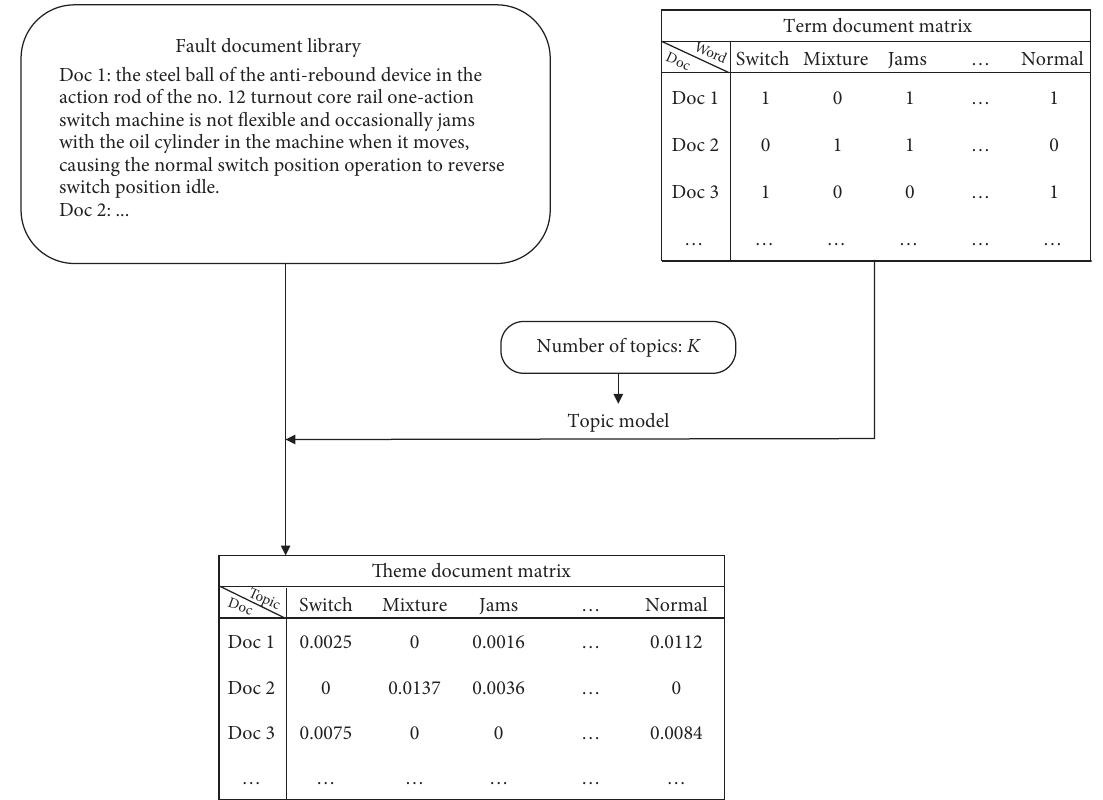
Figure 10: Expression process of fault document in topic space.